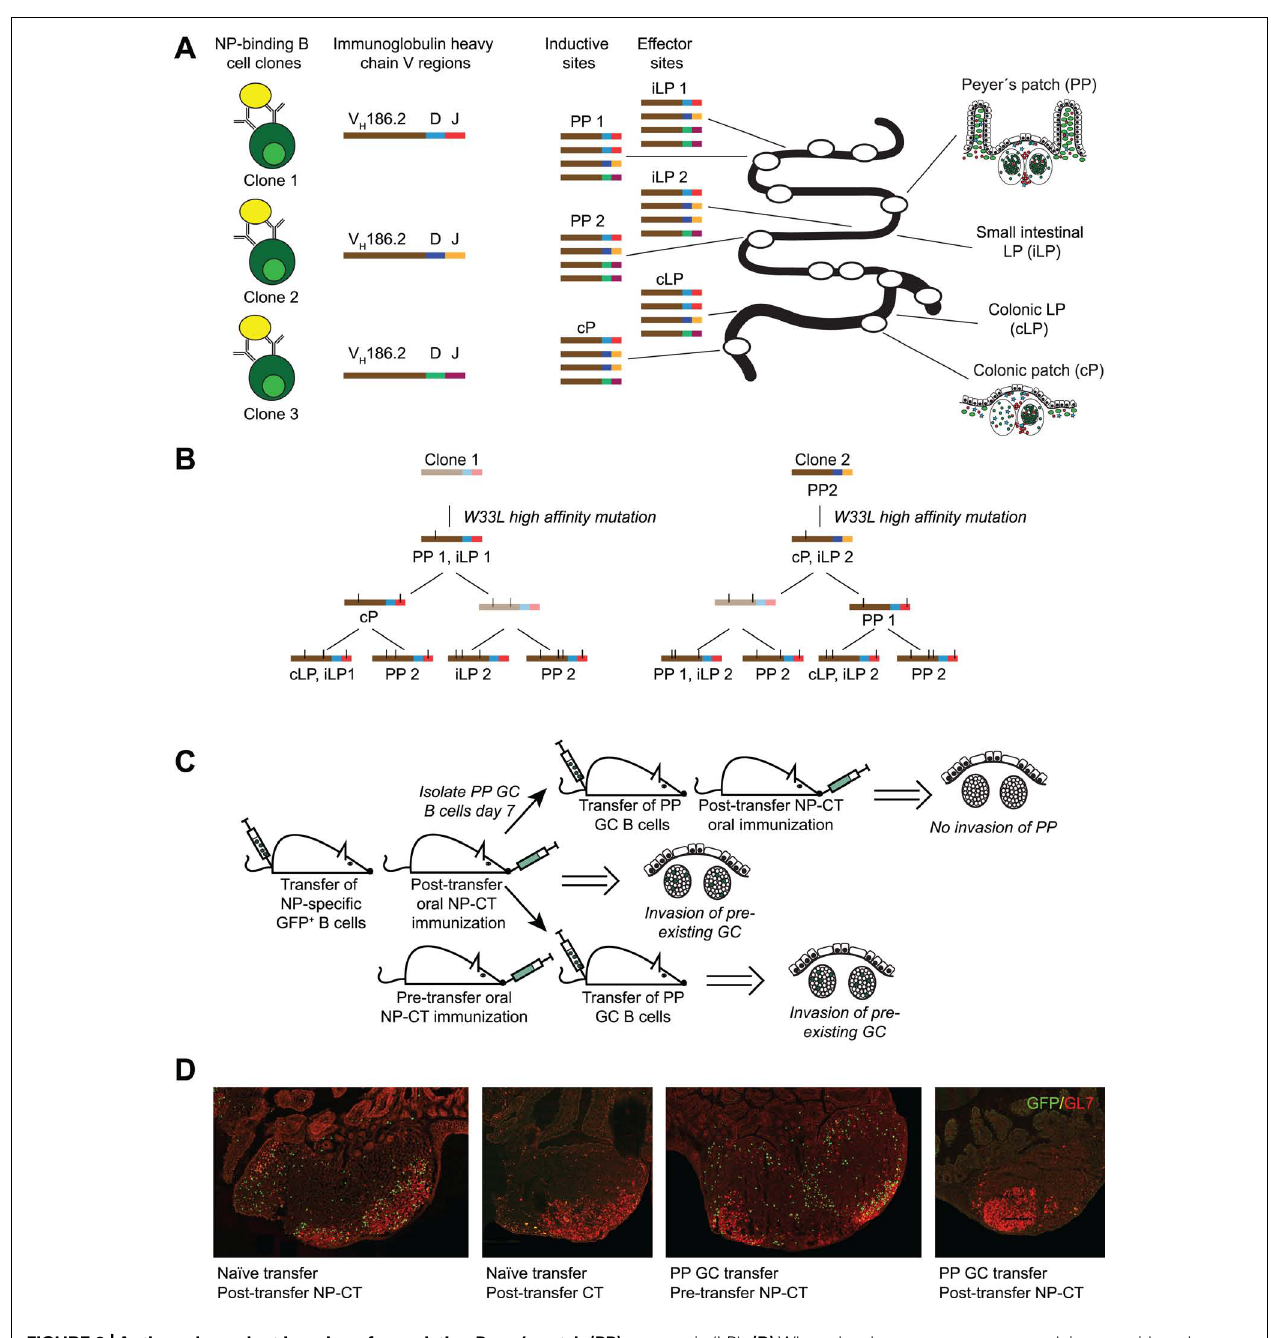
FIGURE 2 |Antigen-dependent invasion of preexisting Peyer’s patch (PP) germinal centers as a mechanism to synchronize gut responses. We recently published a study that demonstrated that IgA responses are synchronized through invasion of pre-existing germinal centers in PP (Bergqvist etal., 2012).This conclusion was based on three observations. (A) The response to NP was dominated by B cells carrying a specific heavy chainV region ( V H 186.2 ). Because antibody sequences differ in the CDR3 region it allows for clonal analysis of the response. Sequencing of V H 186.2-IgA genes from wild-type mice orally immunized with NP-CT demonstrated that the response to NP was highly oligoclonal and that B cells carrying identical CDR3 regions were simultaneously present at distinct inductive sites.This suggested that activated B cells from one inductive site, i.e., one PP GC, could distribute to multiple PP as well as seed the